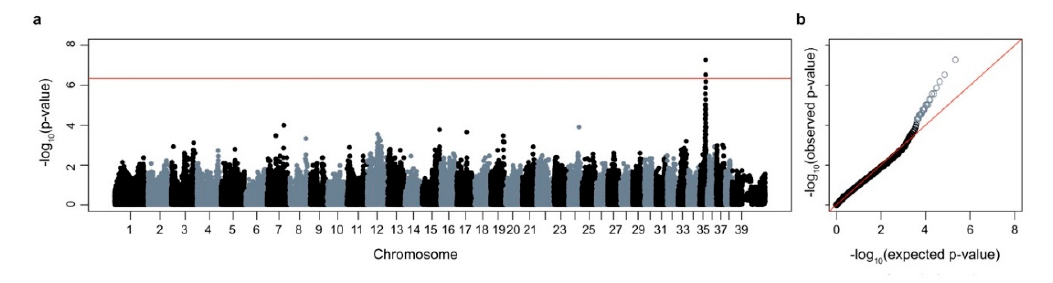
Figure 5. GWAS for SSADHD-affected Saluki dogs. ( a ) Manhattan plot showing –log10 of the raw p-values for each genotyped SNP by chromosome ( x -axis). Genomic inflation was 1.25. Line denotes genome-wide significance based on Bonferroni-corrected p-values. ( b ) Q–Q plot of samples used in GWAS showing the − log10 of the expected versus the observed p-values. The SNPs on CFA35 are shown in light grey.